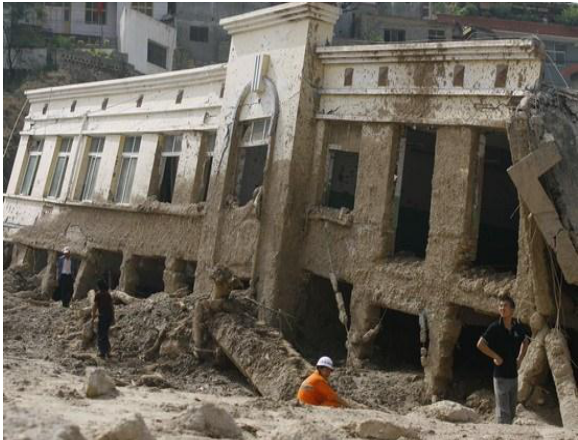
Fig. 14. Two stored building was totally destroyed due to the direct impact of debris flow. 3 Fig. 14. A two-storey building was totally destroyed due to the Mud trance was still remained on the wall of the building. 4 direct impact of debris flow. Mud trance still remained on the wall of the